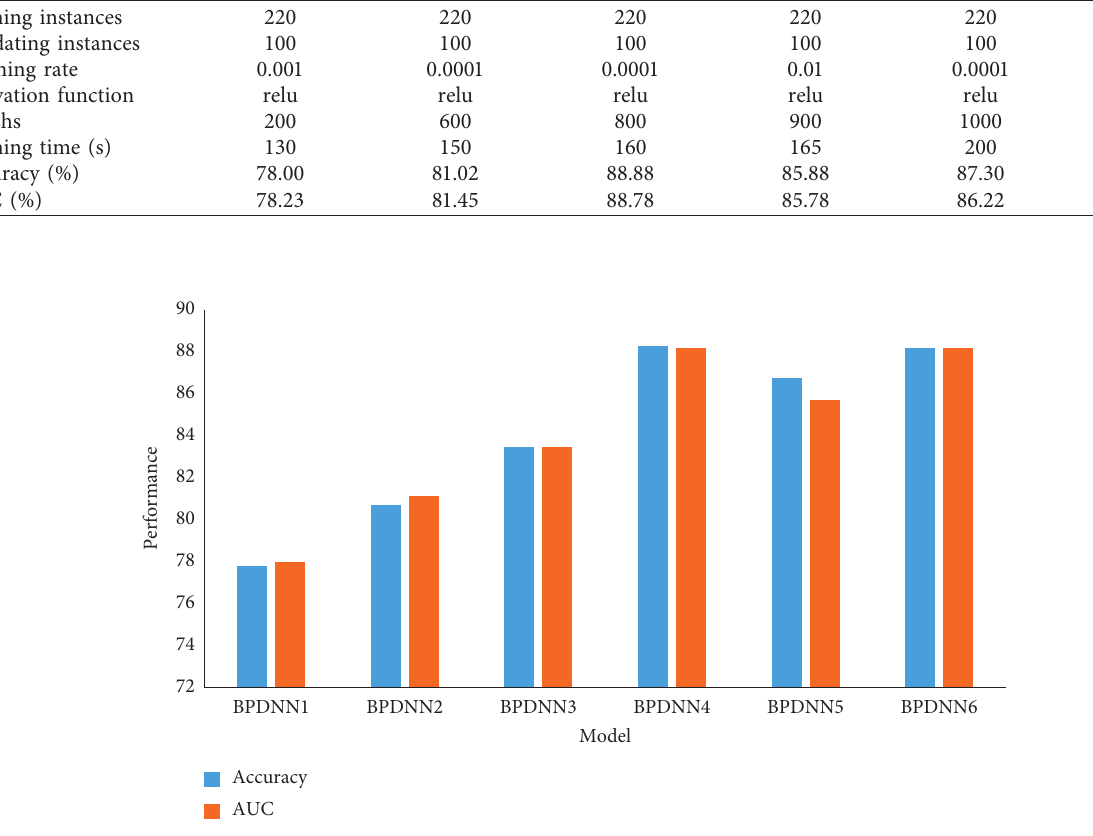
Figure 3: Performance of the BPDNN